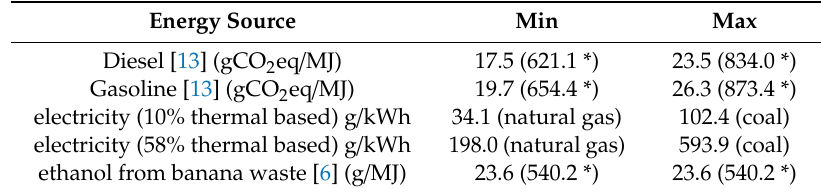
Table 2. Matrix for WTT CO2eq emission factors.